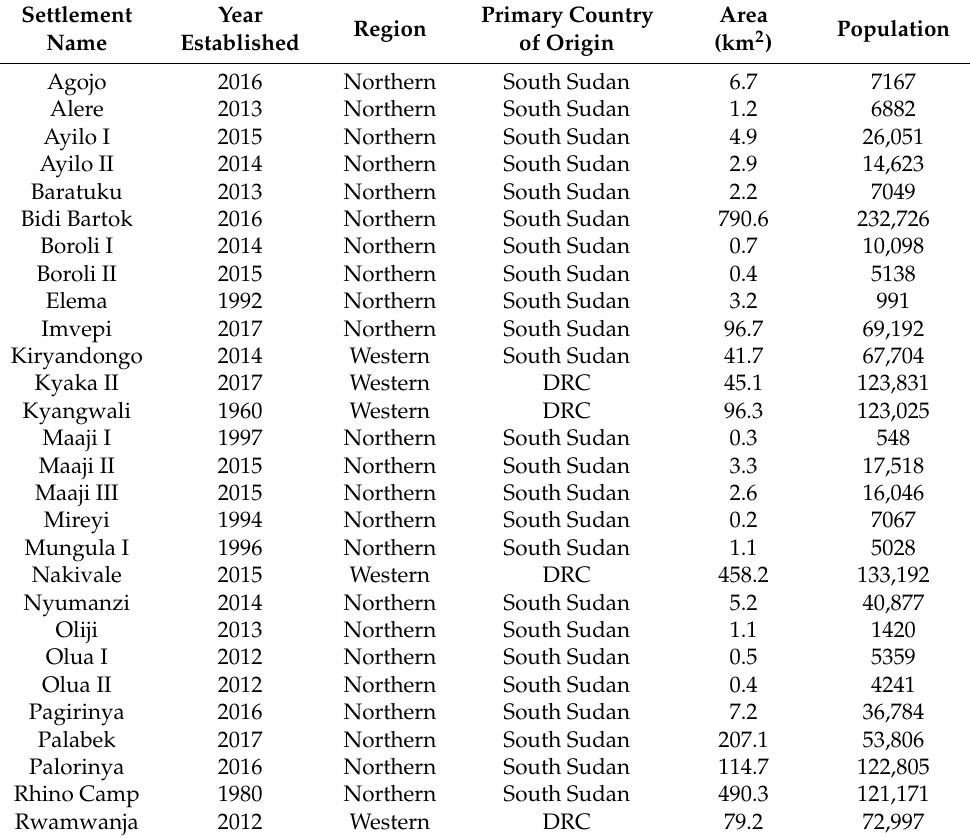
Table 1. Characteristics of 28 study refugee settlements in Uganda. Settlement establishment year data based on UNHCR Settlement Factsheets. Primary country of origin and population data (as of September 2020) from data2.unhcr.org/en/documents/details/79424 (accessed on 1 December 2020). Settlement area based on OSM settlement boundary data. DRC: Democratic Republic of the Congo. Settlement